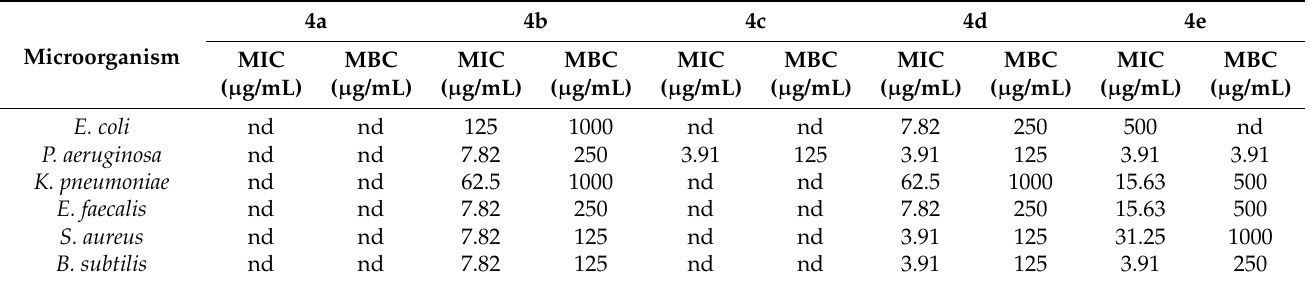
Table 6. MIC ( µ g/mL), MBC ( µ g/mL) of 4a , 4b , 4c , 4d , and 4e towards reference Gram-positive and Gram-negative bacterial strains upon blue light irradiation (see text for details).